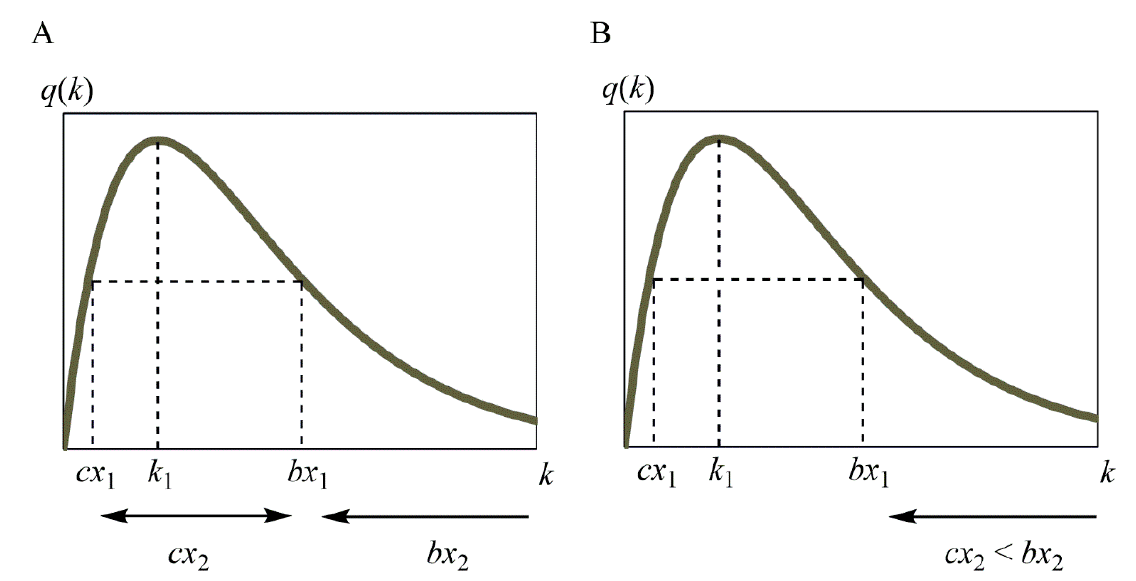
Figure 2. Graphs of q ( k ). q ( cx 1 ) is equal to q ( bx 1 ). The maximizer of q ( k ) is defined as k 1 . ( A ) (iv) cx 1 < cx 2 < bx 1 < bx 2 . q ( cx 2 ) is greater than q ( bx 1 ) and q ( cx 1 ). q ( bx 2 ) is less than q ( bx 1 ). ( B ) (v) cx 1 < bx 1 < cx 2 < bx 2 . q ( cx 2 ) is less than q ( bx 1 ) and q ( cx 1 ). q ( bx 2 ) is less than q ( cx 2 ).